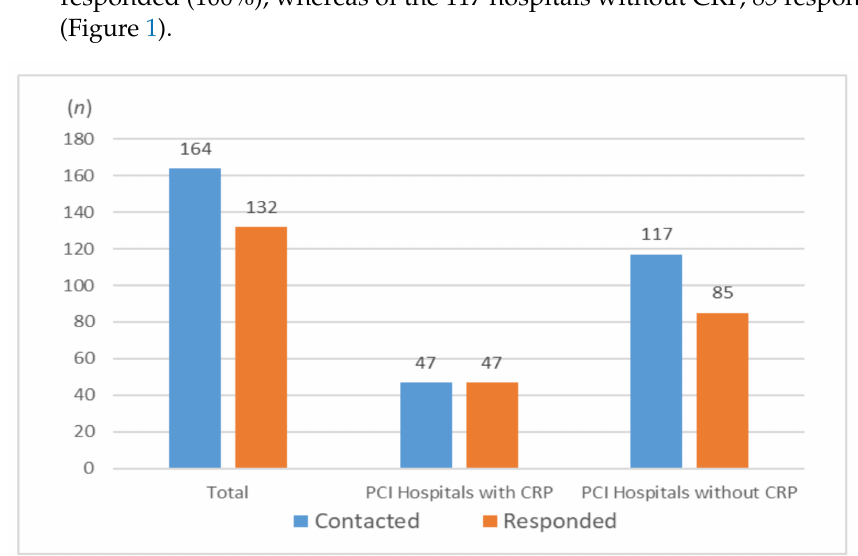
Figure 1. The response rates according to hospitals, with and without cardiac rehabilitation programs